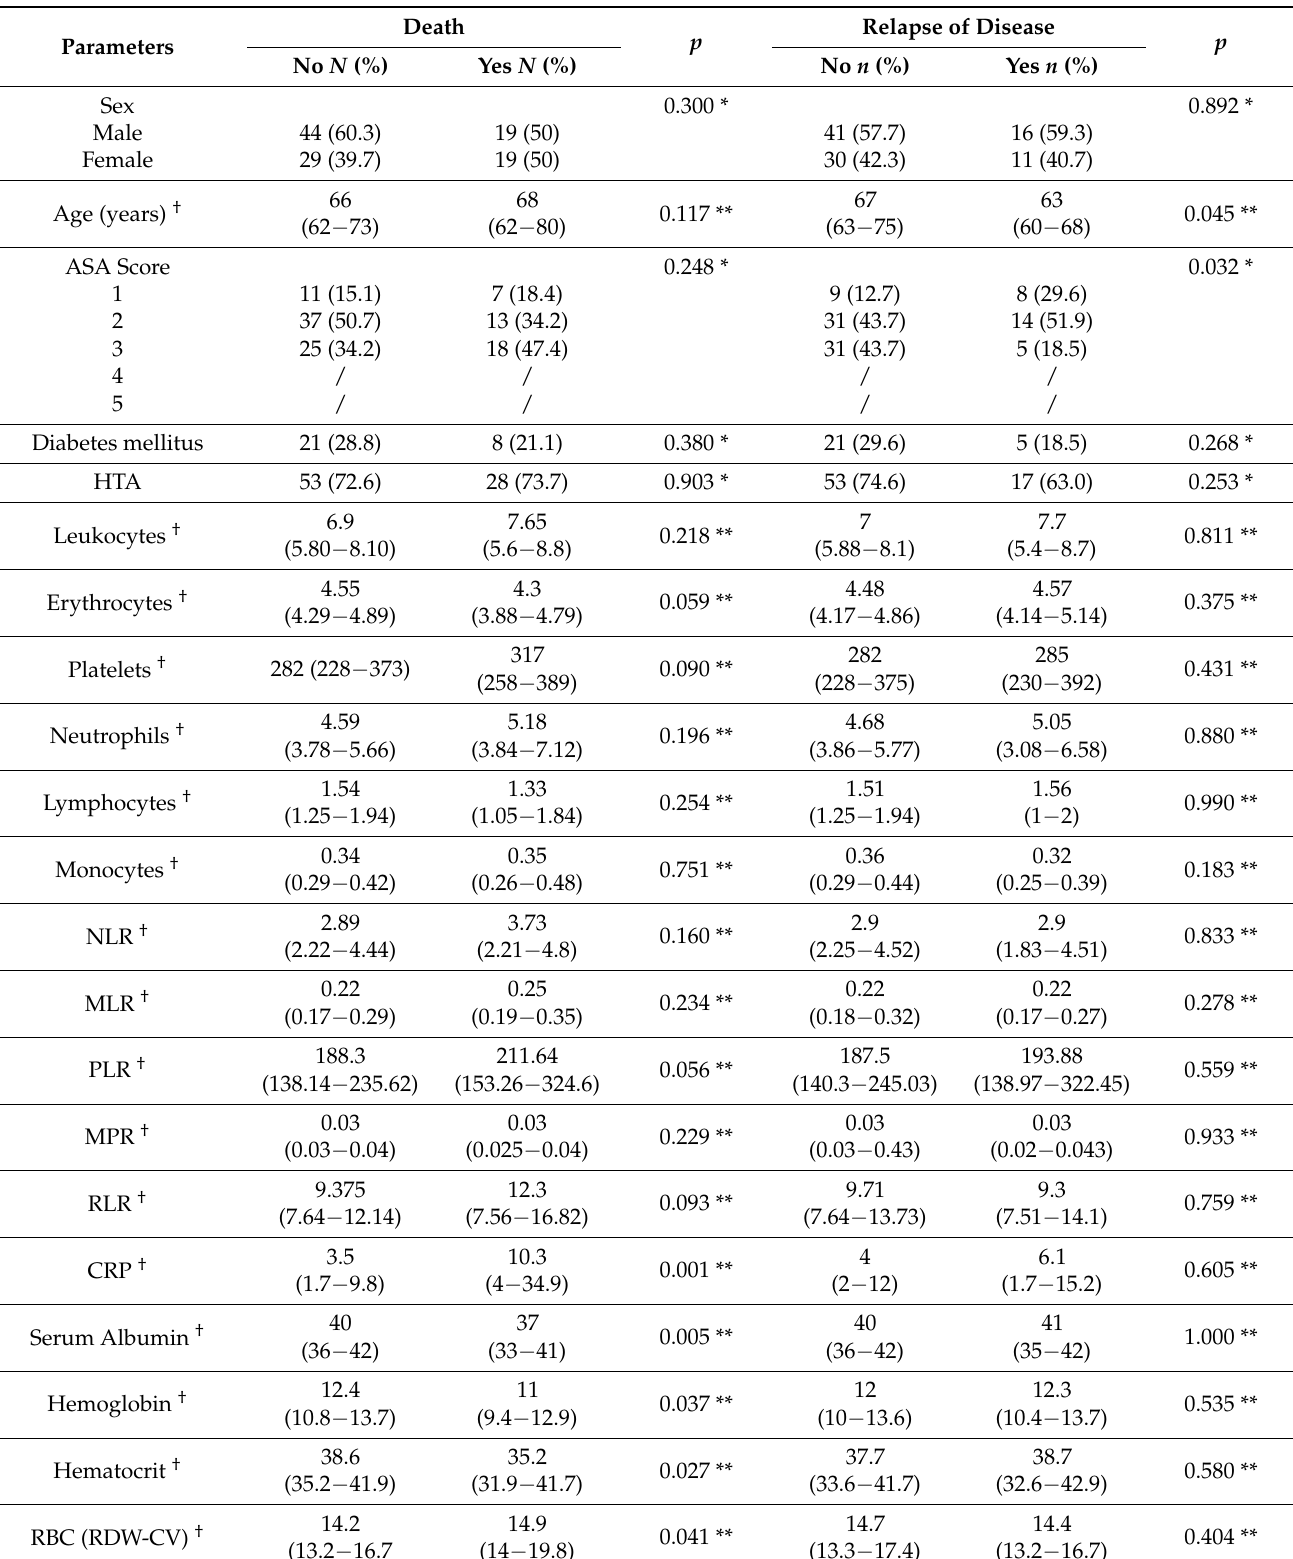
Table 2. Clinical and pathohistological characteristics in relation to overall survival and disease